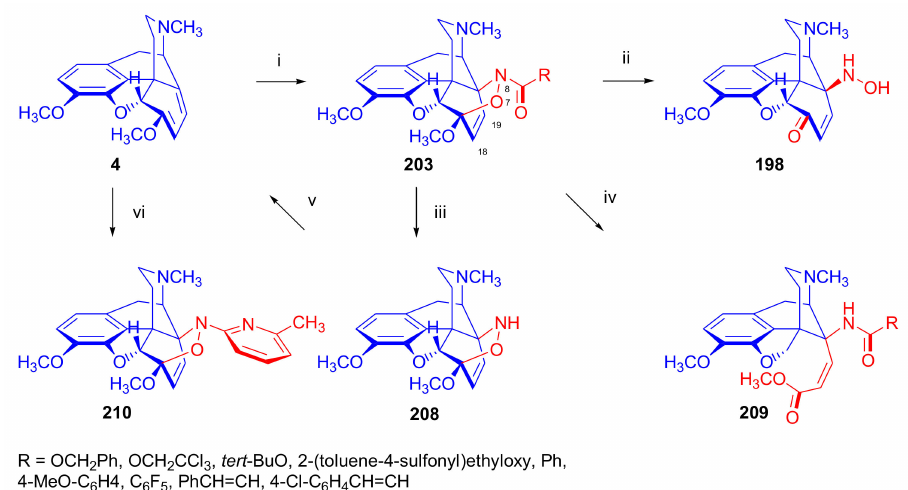
Figure 56. Synthesis of thebaine acyl nitroso HDA adducts. Reagents and conditions : (i): N - hydroxycarbamic esters, Et 4 NIO 4 or BnMe 3 NIO 4 , CH 2 Cl 2 , 0 ◦ C; (ii): from 203 R = tert Bu, HCl in MeOH, 90%; (iii): DBN, benzene, room temperature, 1 h, 56%; and (iv): two equiv. SmI 2 , THF, argon, 0 ◦ C, 3 h, 77%; (v): attempted recrystallization.